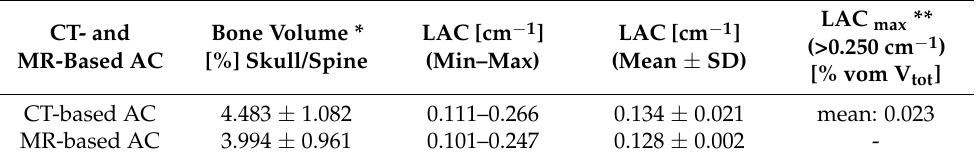
Table 2. Comparison of CT- and MR-based bone information in the attenuation correction maps (AC maps) of all patient data sets. Bone volume and corresponding linear attenuation coefficients (LAC) were measured in patients’ skull and spine (head-neck region). Note that the last column refers to the small volume and overall small percentage of voxels with high LAC in CT-based AC that is caused by dental